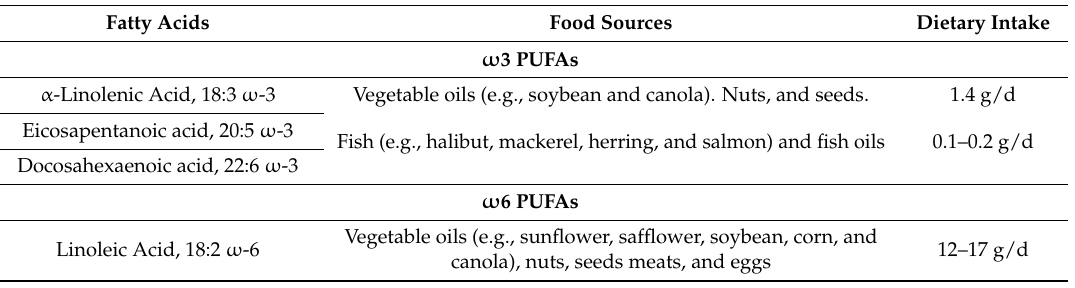
Table 3. Food sources and dietary intake of major ω -3 and ω -6 fatty acids